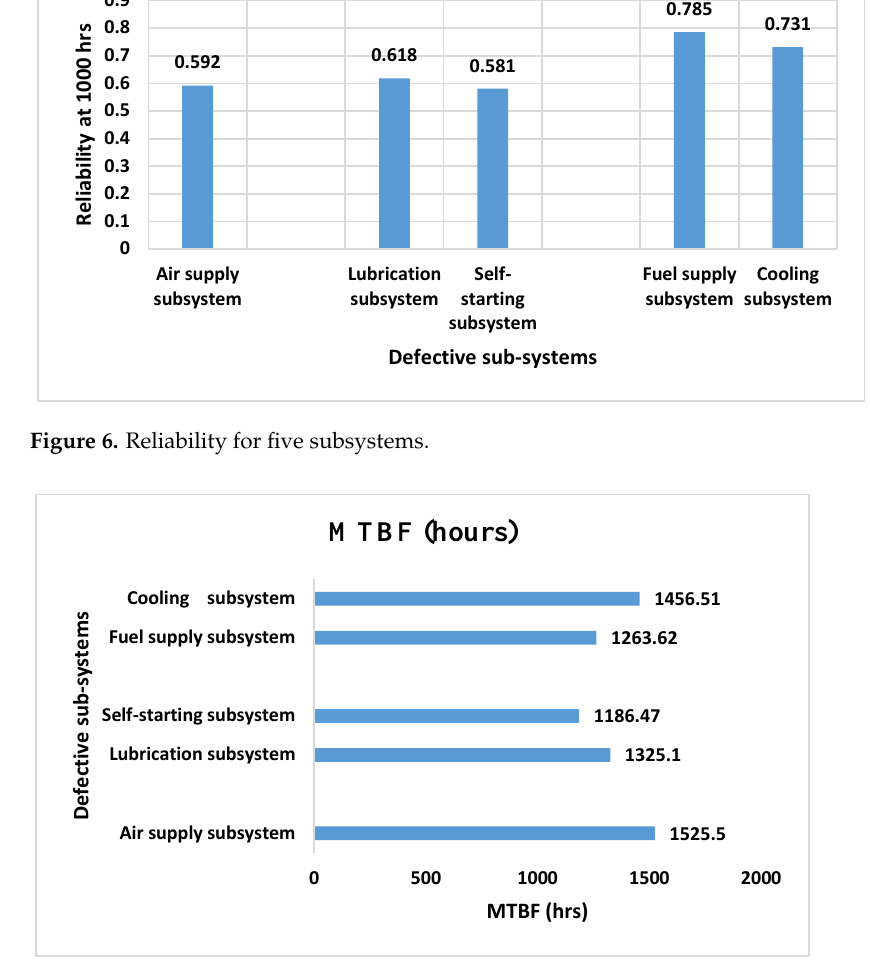
Figure 7. MTBF for five subsystems.